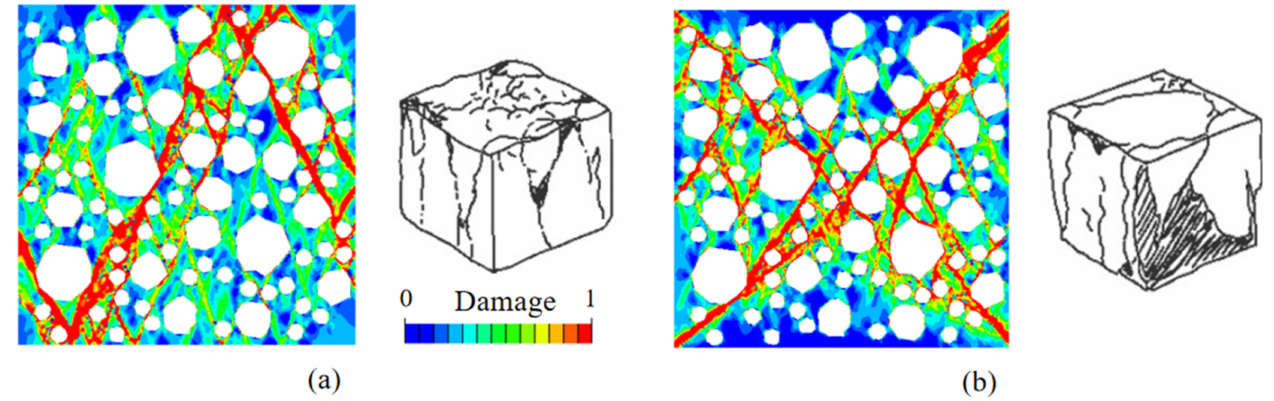
Figure 9. Two representative failure modes of uniaxial compression under different boundary